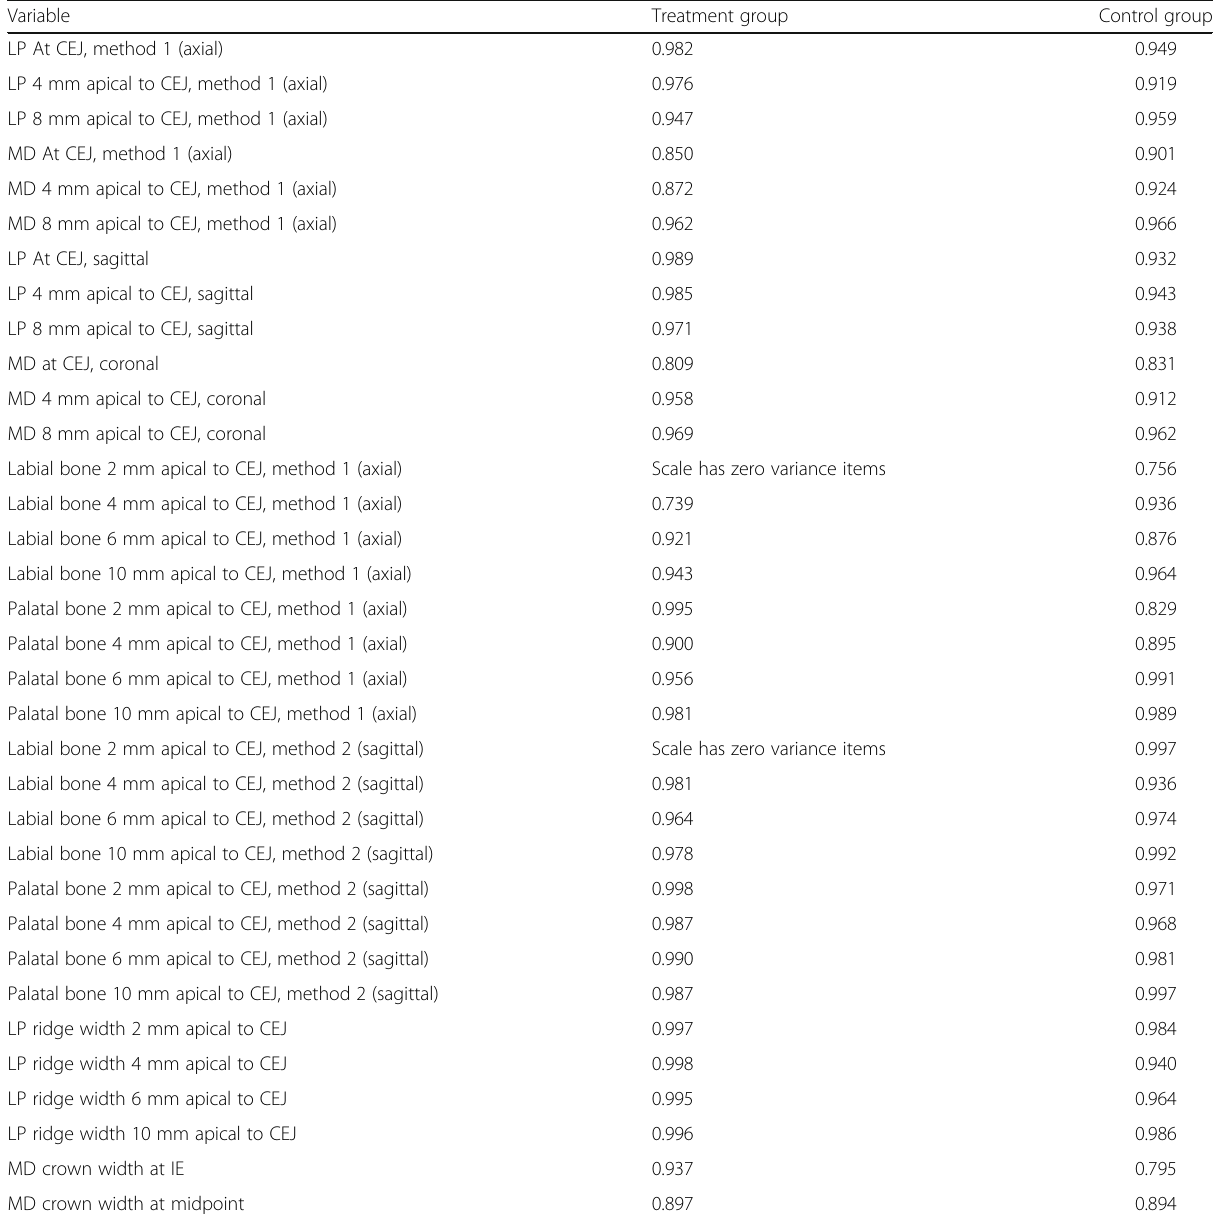
Table 2 Reliability analysis for the different measurements: Cronbach alpha values